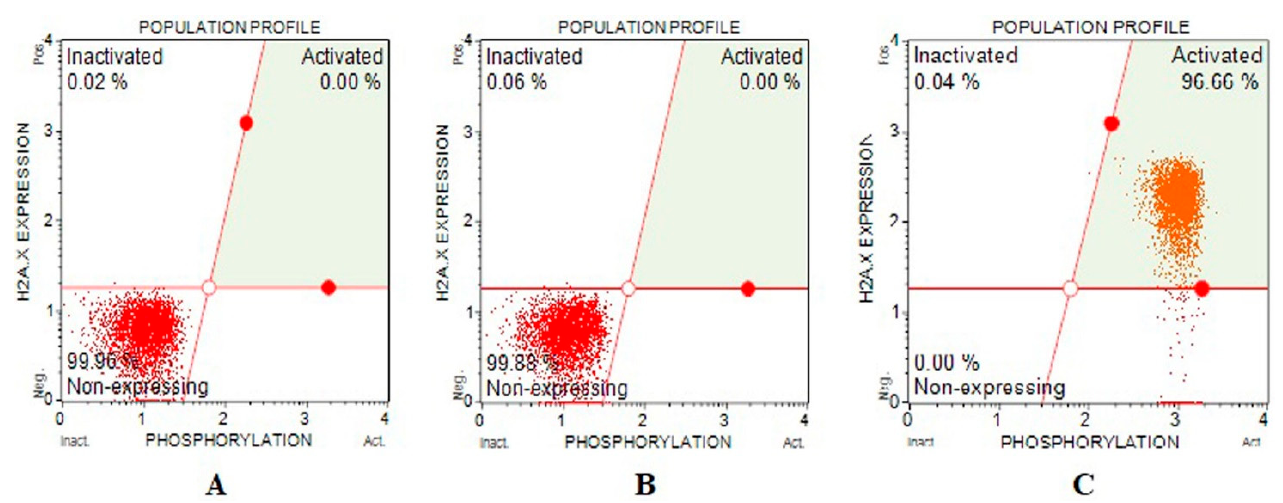
Figure 4. Sample plots to γ H2AX assay from Muse Cell Analyzer. ( A ) Growth control; ( B ) IC25; ( C ) IC75.